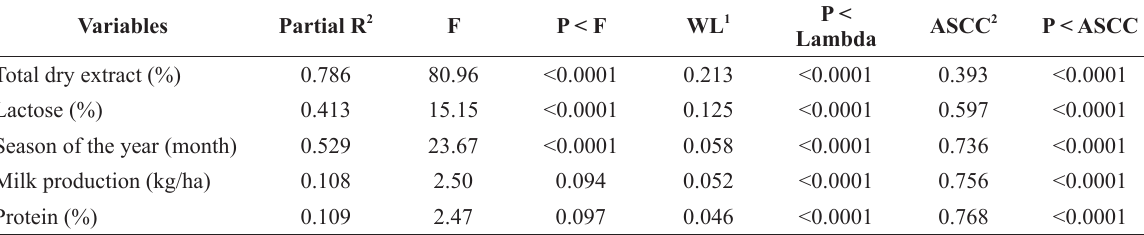
Discriminant analysis of the determinant variables for differentiation of the groups and their respective statistical parameters of milk production and composition data according to the seasons of the year, microbiological quality of milk, and health of the mammary